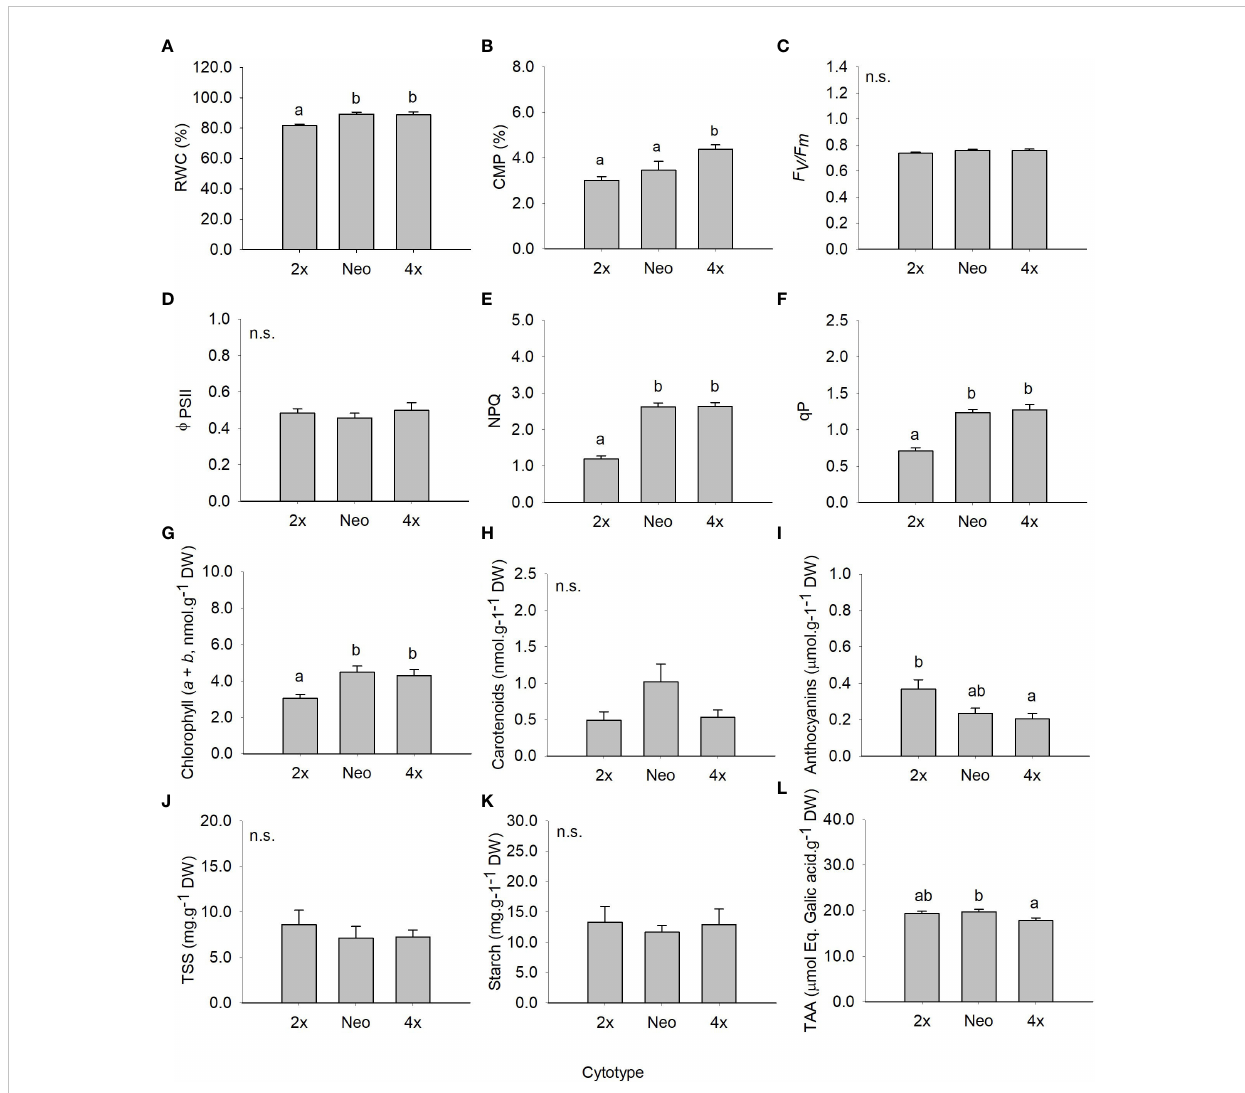
FIGURE 2 Mean (± SE) for relative water content (A) , cell membrane permeability (B) , maximum quantum ef fi ciency of photosystem II (C) , effective quantum ef fi ciency of PSII (D) , non-photochemical quenching (E) , photochemical quenching (F) , chlorophyll ( a+b ) (G) , carotenoid content (H) , anthocyanin ’ s content (I) , total soluble sugars (J) , starch content (K) and total antioxidant capacity (L) of diploids, neotetraploids and tetraploids Jasione maritima var maritima of contact zone populations grown under control conditions. Signi fi cant differences at P < 0.05 among cytotypes are indicated by different letters. n.s. indicated the absence of signi fi cant